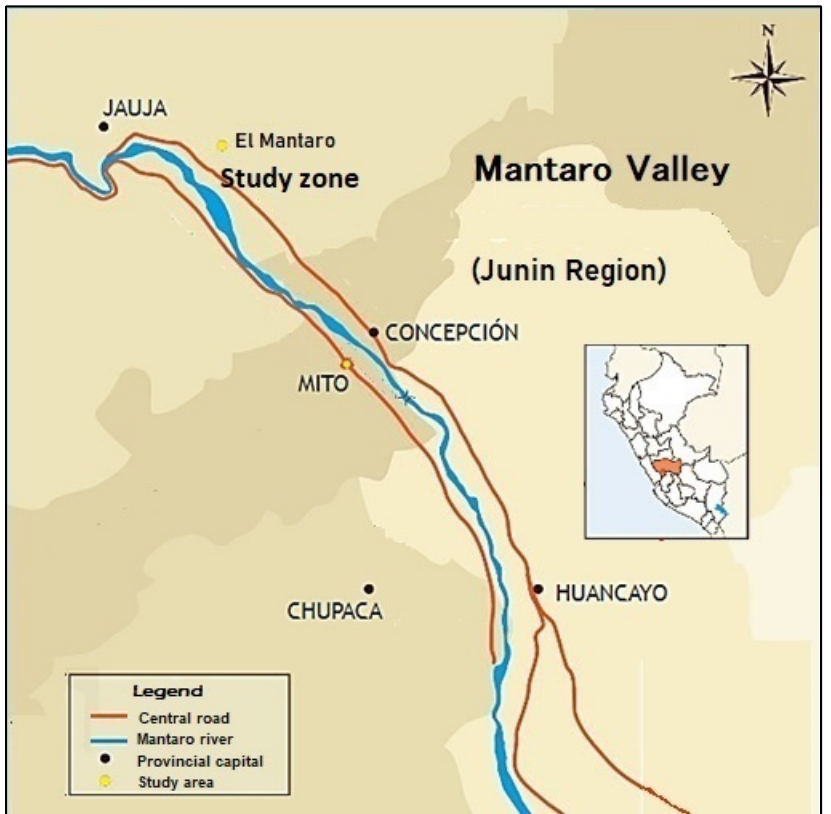
Figure 1. Map of the Mataro Valley—Study Area, Mantaro River left bank.